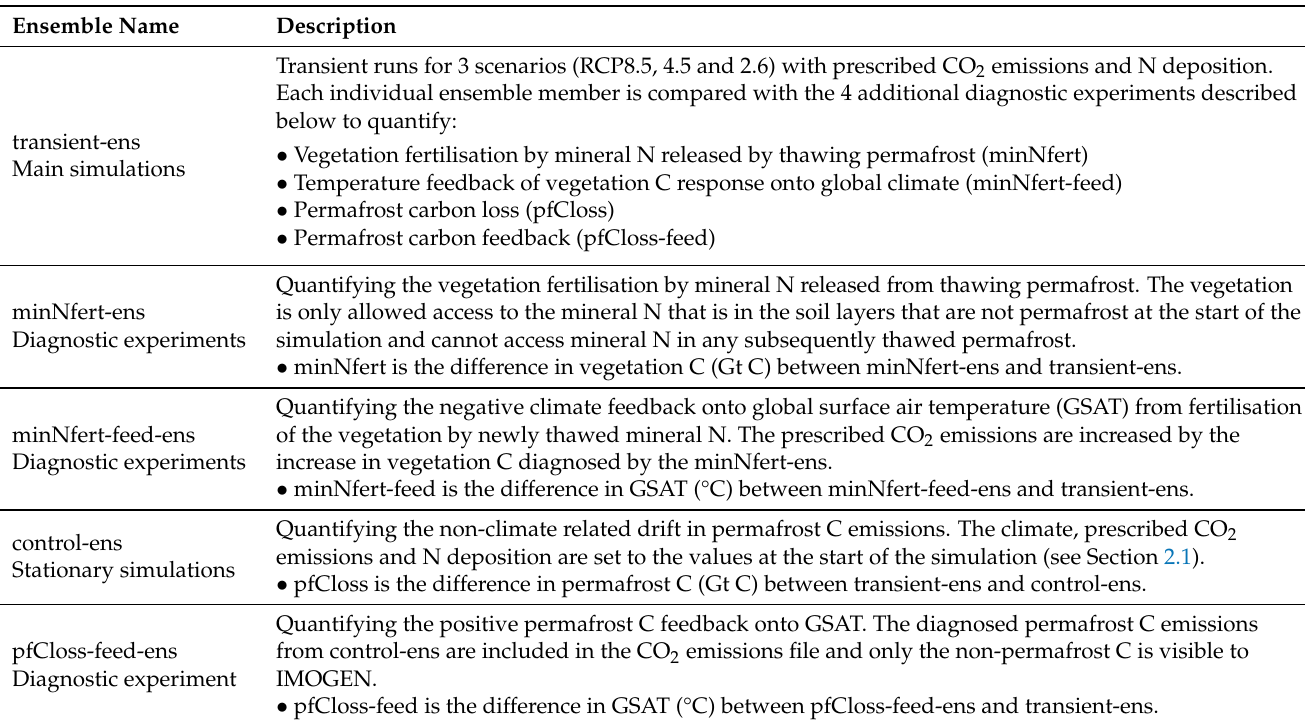
Table 2. List of ensemble simulations assessed here—the transient simulation plus diagnostic ex- periments. These diagnostic experiments are required to quantify the mineral N fertilisation on vegetation C (minNfert) and its climate feedback (minNfert-feed) and the permafrost C loss (PfCloss) and permafrost climate feedback